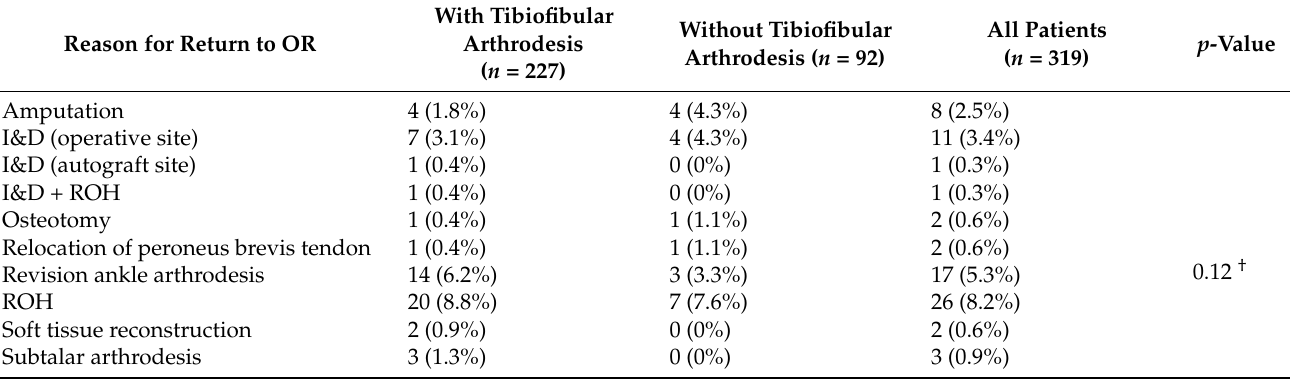
Table 9. Reason for return to OR by procedure type, excluding planned removal of external